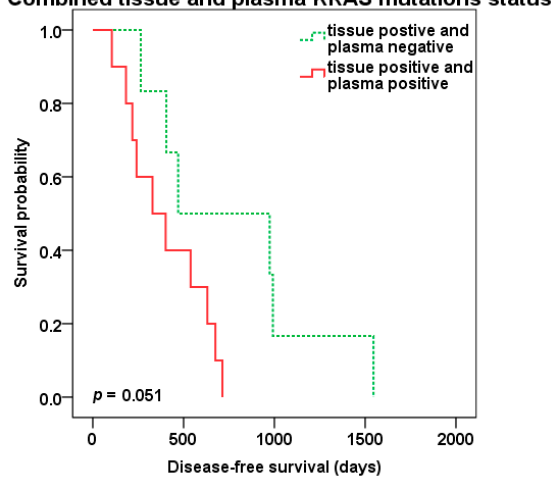
Figure 5. Disease-free survival (DFS) after liver surgery in patients with combined KRAS liver metastasis tissue and preoperative plasma positivity (red color) vs. tissue positivity only (green color dotted line).